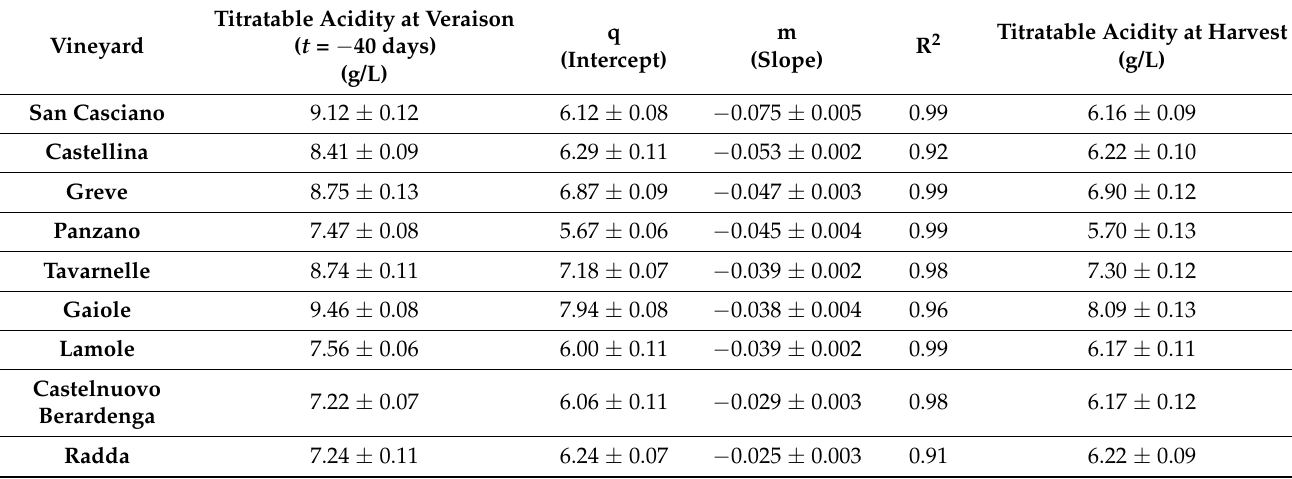
Table 6. Calculated values of the functional parameters, intercept, slope and R 2 of the titratable acidity inside the grapes coming from the different vineyards.